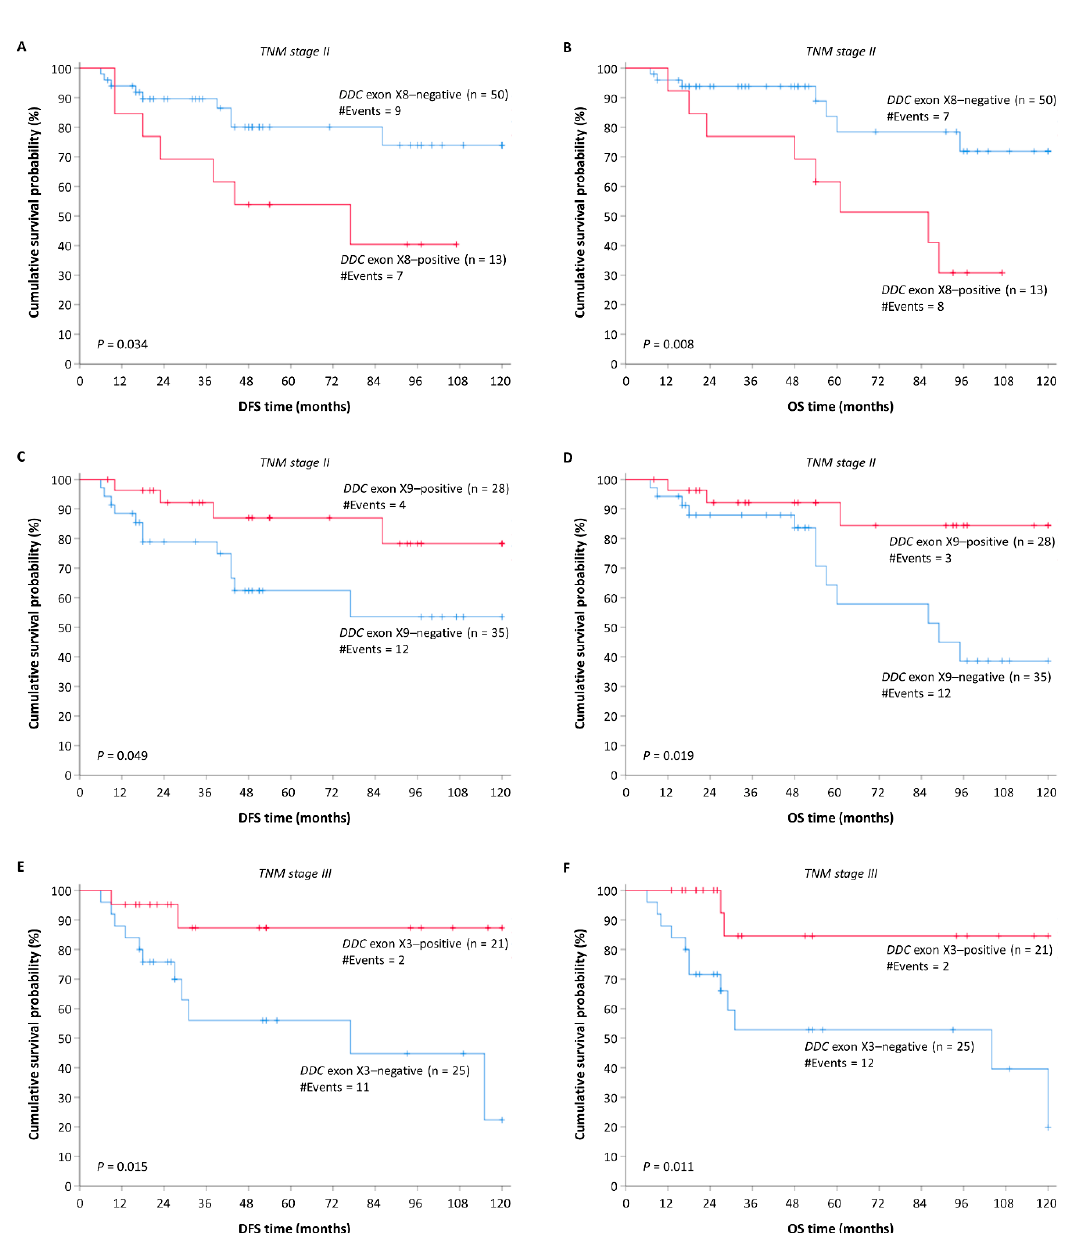
Figure 6. Stratified Kaplan–Meier survival curves of groups of patients with substantially different prognoses according to TNM stage. Patients with DDC exon X8-positive tumors in TNM stage II have ( A ) a shorter DFS and ( B ) OS time period compared to those with DDC exon X8-negative tumors. Patients with DDC exon X9-positive tumors in TNM stage II have ( C ) a higher DFS and ( D ) OS time period compared to those with DDC exon X9-negative tumors. Patients with DDC exon X3-positive tumors in TNM stage III have ( E ) a higher DFS and ( F ) OS time period compared to those with DDC exon X3-negative